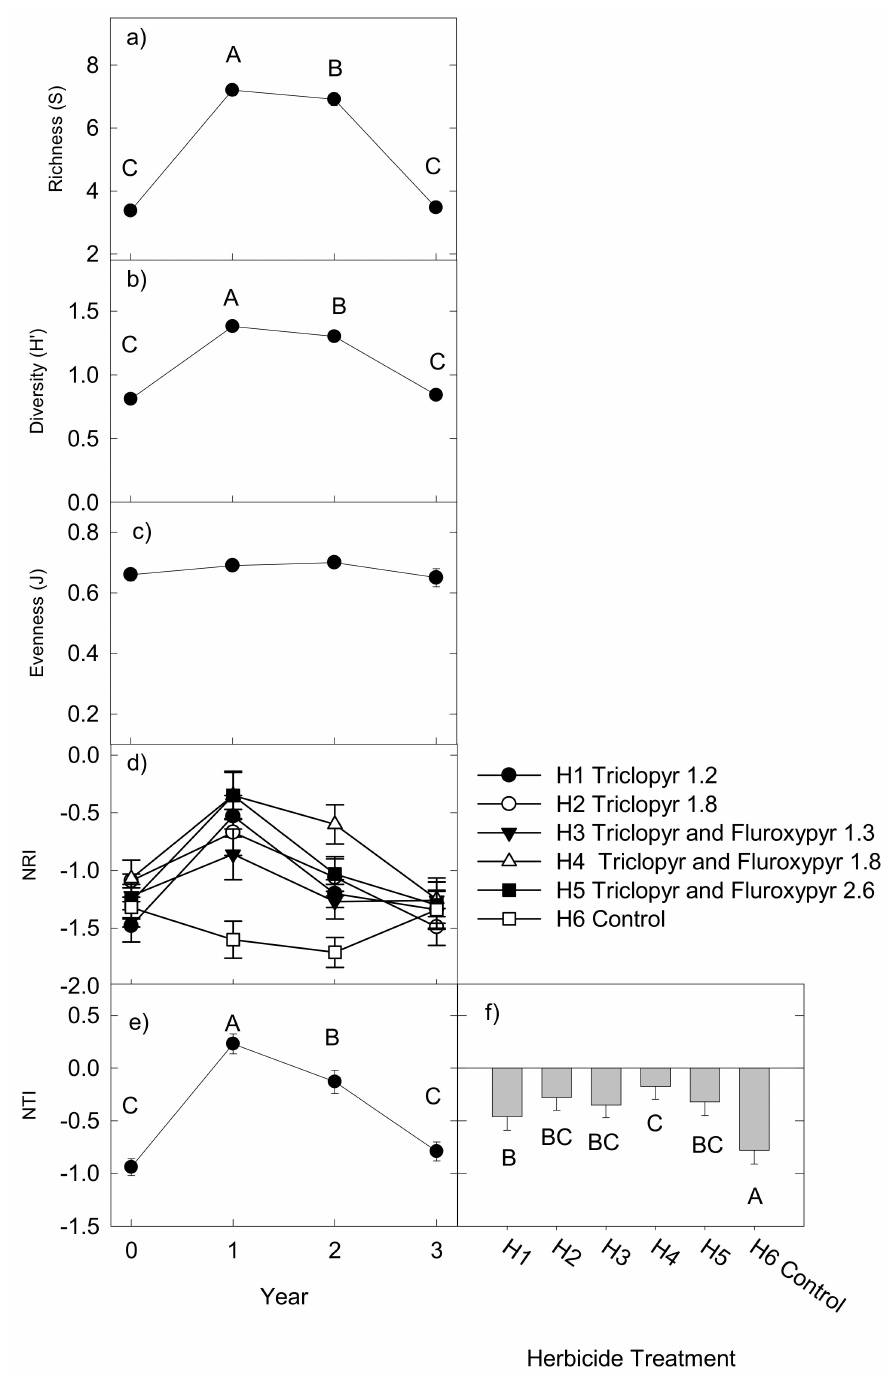
Figure 2. Measures of diversity over four years across three sites (significance shown in Table 1). Mean values sharing the same letter are not significantly di ff erent ( p < 0.05). An interaction between year and herbicide treatment only occurred for NRI (net relatedness index; ( d ) herbicide treatments (H1–H5, H6 = control per Table 3). An herbicide main e ff ect only occurred for NTI (nearest taxon index; ( f )). Panels ( a – c , e ) show mean values across herbicide treatments per year (solid circle) ± standard error